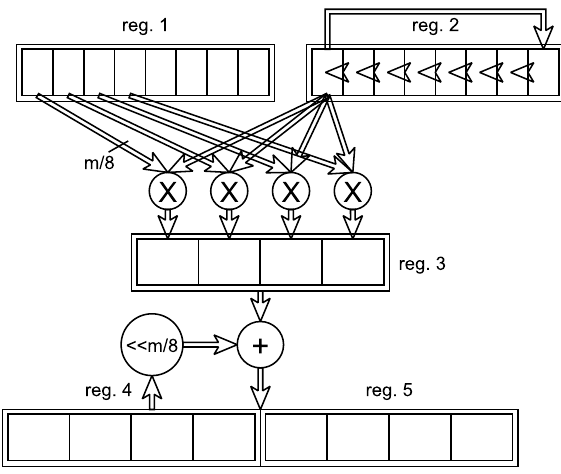
Figure 3. Structure of the Karatsuba